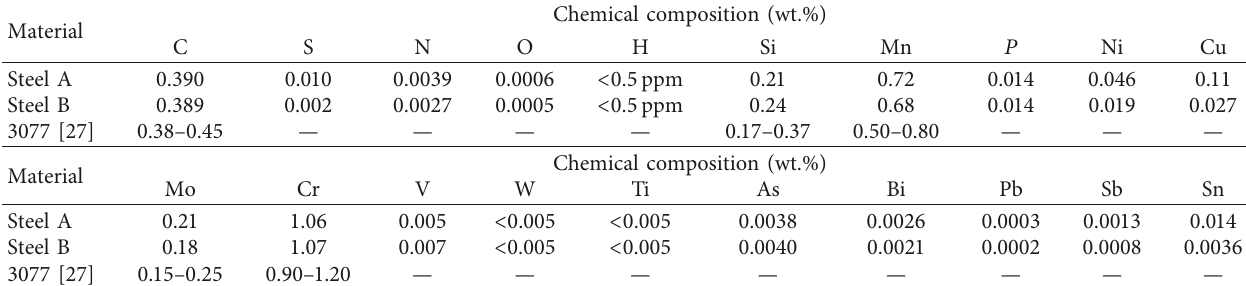
Table 1: Chemical composition of 42CrMo steels of Steel A and Steel B (in wt.%). Chemical composition Material